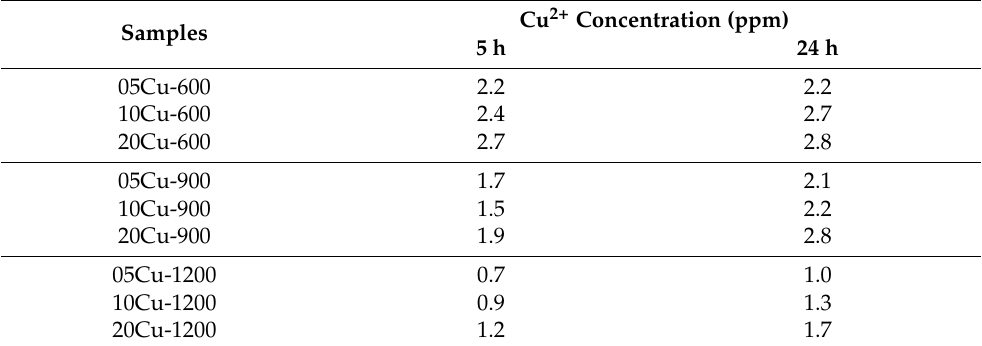
Table 3. Average values (from the nine replicates realized on the four strains) of Cu 2+ release (ppm) in 1:500 diluted TS medium measured by MP-AES during antibacterial assays of the Cu- doped bioceramics.